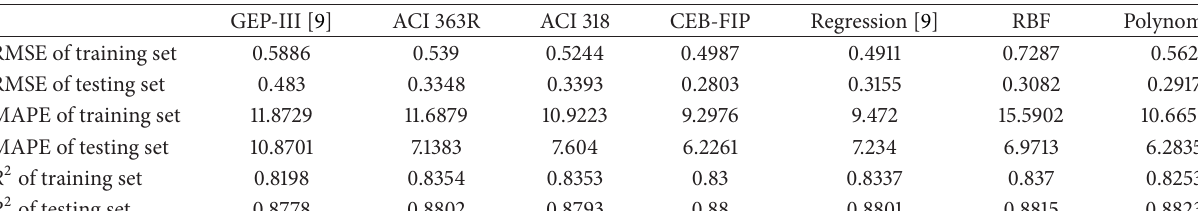
Table 7: Error measurement for 𝑓